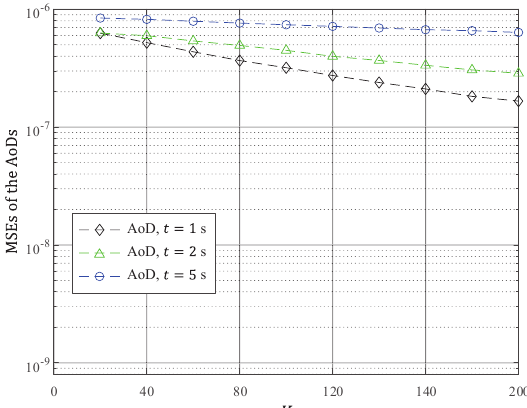
Figure 4. MSEs of the complex CIR of the WSSUS channel models for V2V communications with respect to the distance D 0 .